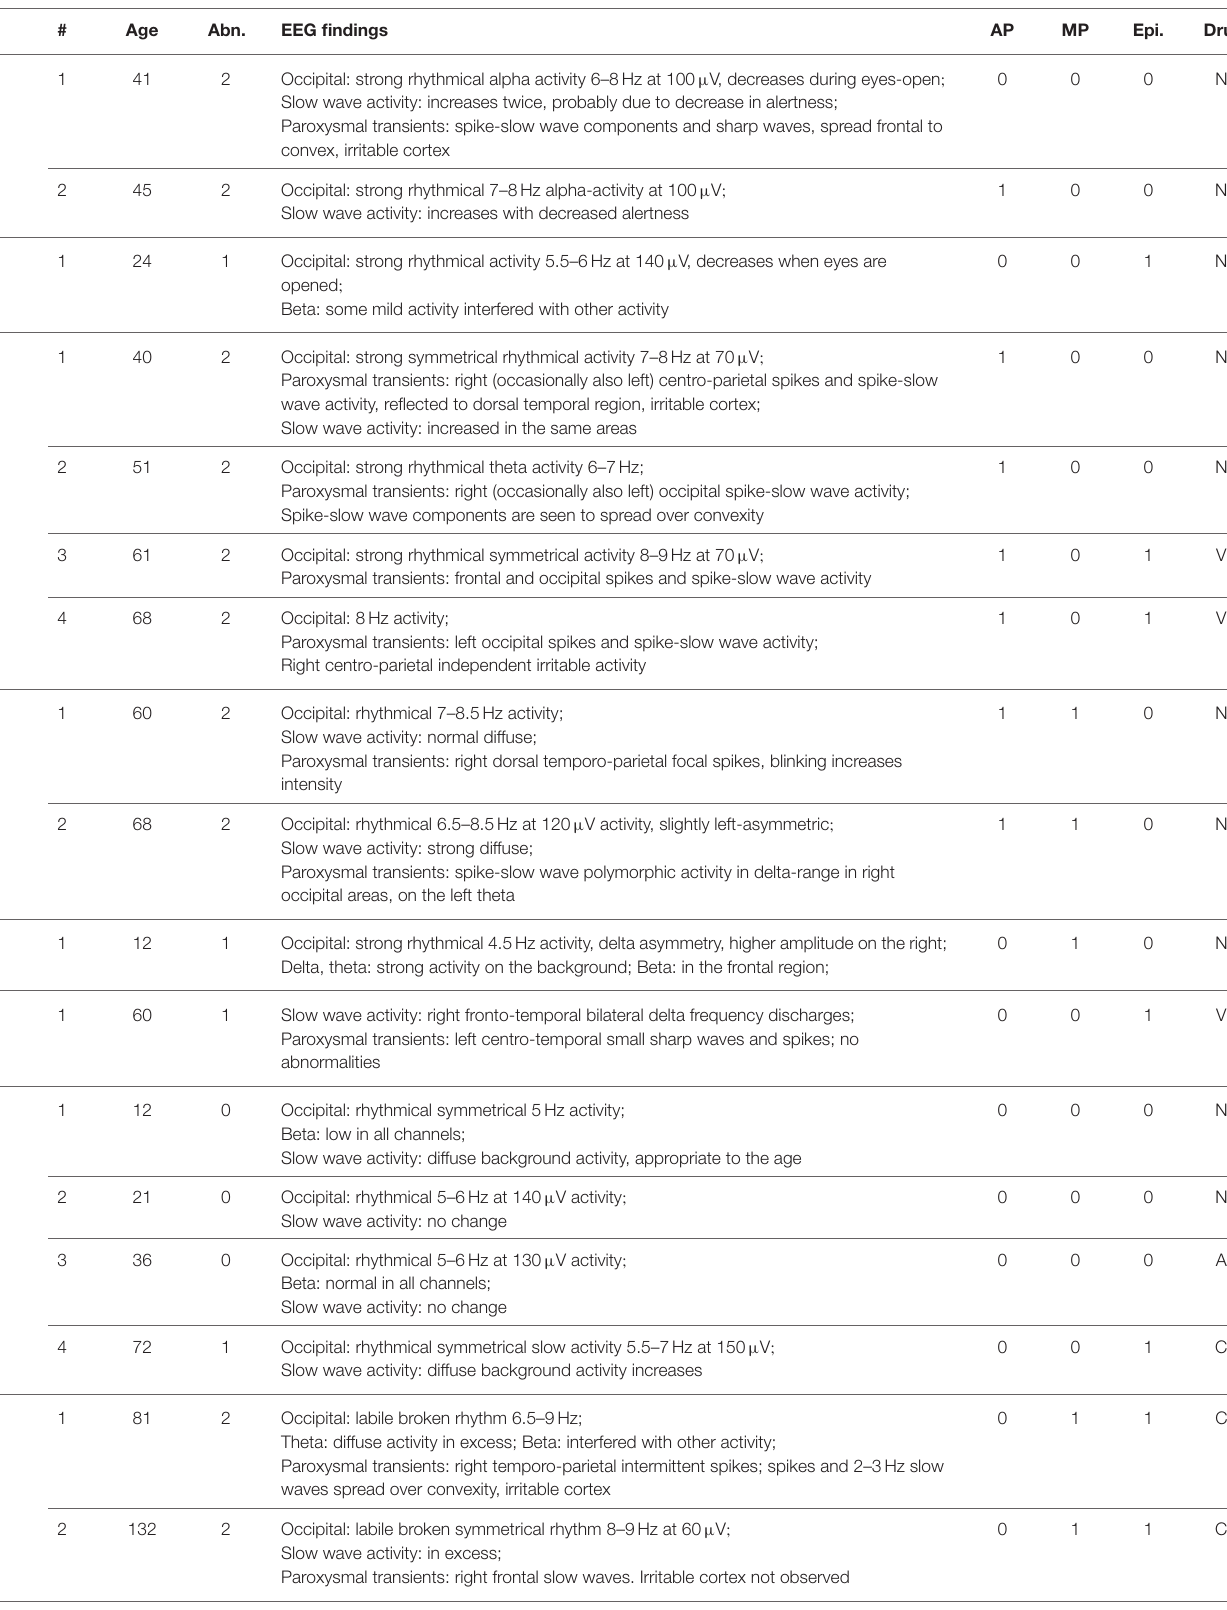
TABLE 1 | Abridged findings from clinical observation notes for waking EEG and